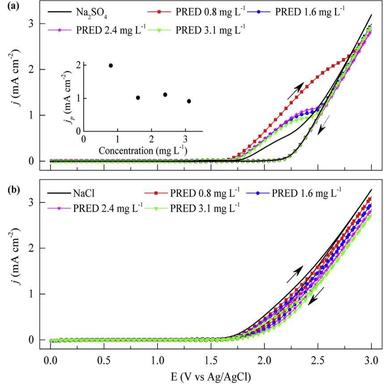
Cyclic voltammogram response in the absence or adding step-by-step PRED in background solution containing (a) 1 g L1 of Na2SO4 (input graphic represents the relation between the pollutant concentration and the peak current density), and (b) 1 g L1 of NaCl.